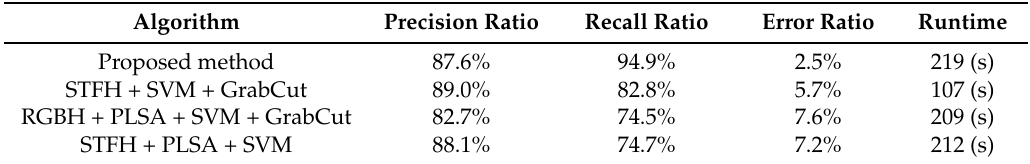
Table 3. Cloud detection performance analysis of internal feasibility.